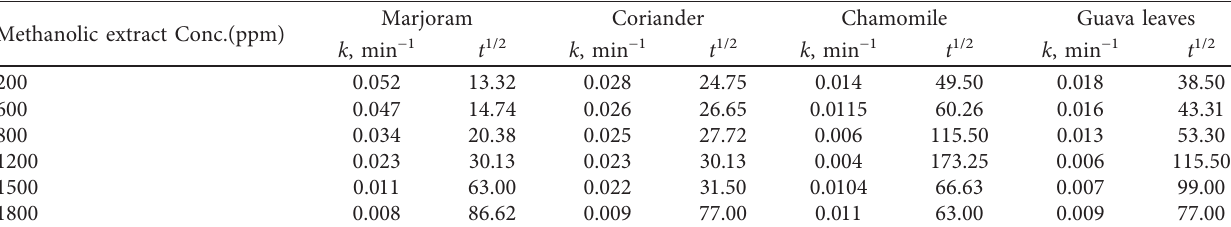
3 PO 4 solutions containing different concentrations of